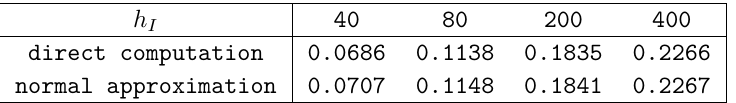
Table 2: Direct computation and normal approximation for I ( p, A (1) , 1 ,